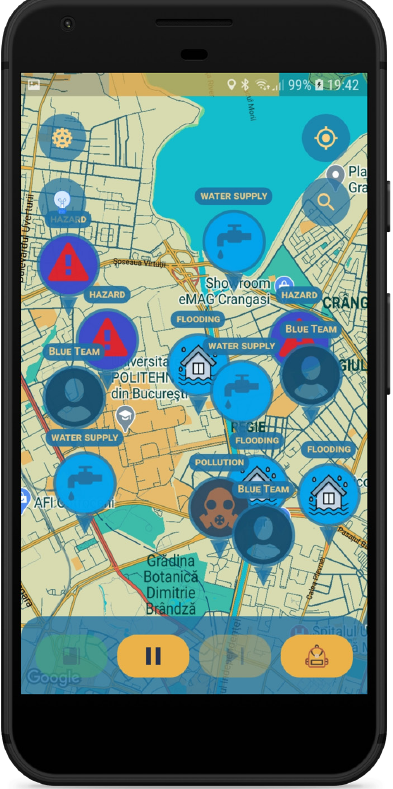
Figure 11. Watergame mobile application prototype.